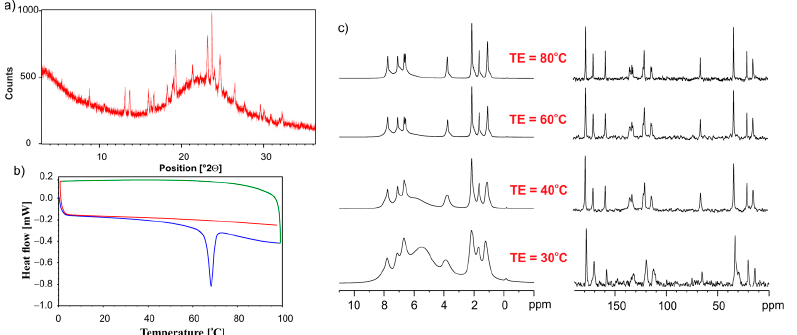
Figure 9. ( a ) PXRD recorded on a PANalytical 3 kW system in Bragg–Brentano geometry and with a Cu K α ( λ = 1.5425 Å) source, ( b ) the DSC measurement. The first heating run from 0 ◦ C to 100 ◦ C (blue line), then a cooling run from 100 ◦ C to 0 ◦ C (green line), followed by a second heating run from 0 ◦ C to 100 ◦ C (red line), ( c ) VT NMR data 1 H MAS (left column) and 13 C CP MAS (right column) recorded with a spinning rate of 12 kHz for the physical mixture of ET:GLU cocrystal and SiO 2(hydr) The amorphization of the sample was also achieved when a mixture of the ET:GLU cocrystal and SiO 2(hydr) was neatly grinded using the ball mill. Figure 10a shows the PXRD di ff ractogram, and Figure 10b shows DSC pro fi les. The NMR spectra are shown in Figure 10c ( 1 H MAS), Figure 10d ( 13 C CP/MAS), and Figure 10e ( 13 C SPE MAS). All presented data clearly prove that the grinding procedure leads to amorphization. Figure 10. The ( a ) PXRD recorded on a PANalytical 3 kW system in Bragg–Brentano geometry and with a Cu K α ( λ = 1.5425 Å) source, ( b ) the DSC measurement. The fi rst heating run from 0 °C to 100 °C (blue line), then a cooling run from 100 °C to 0 °C (green line), followed by a second heating run from 0 °C to 100 °C (red line), ( c ) 1 H MAS, ( d ) 13 C CP MAS and ( e ) 13 C SPE MAS NMR measure- ments recorded with a spinning rate of 12 kHz for the physical mixture of ET:GLU cocrystal and SiO 2(hydr) after grinding in a ball mill.